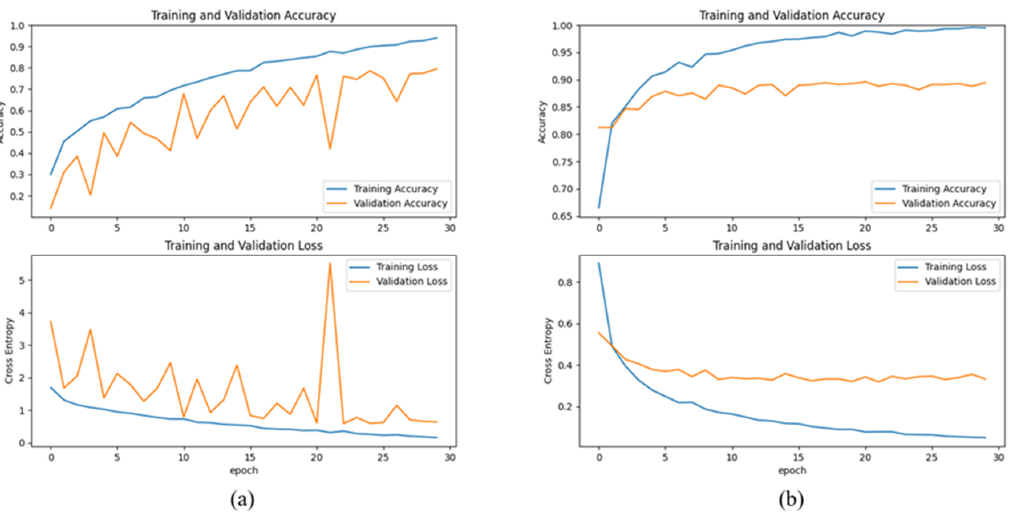
Figure 9. Accuracy and loss of the training set and validation set for each epoch: ( a ) CNN, ( b ) Mo- bileNet.